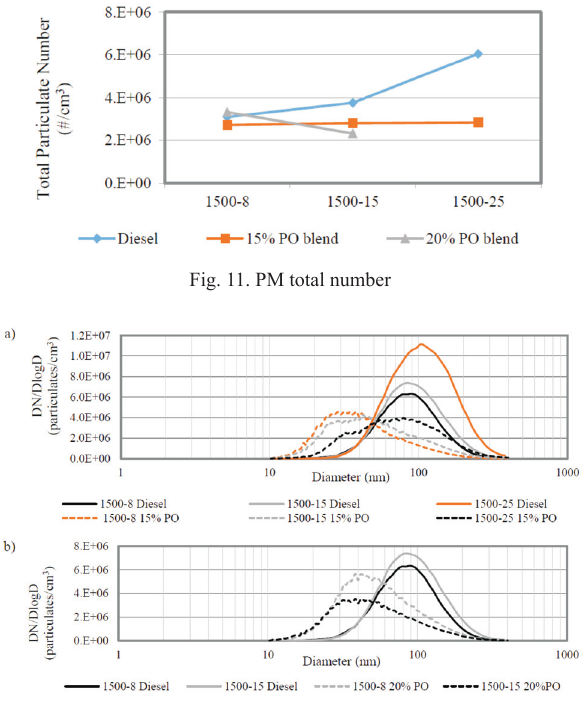
Fig. 12. PM emissions Batch (ii): a) 15% PO blend and b) 20% PO